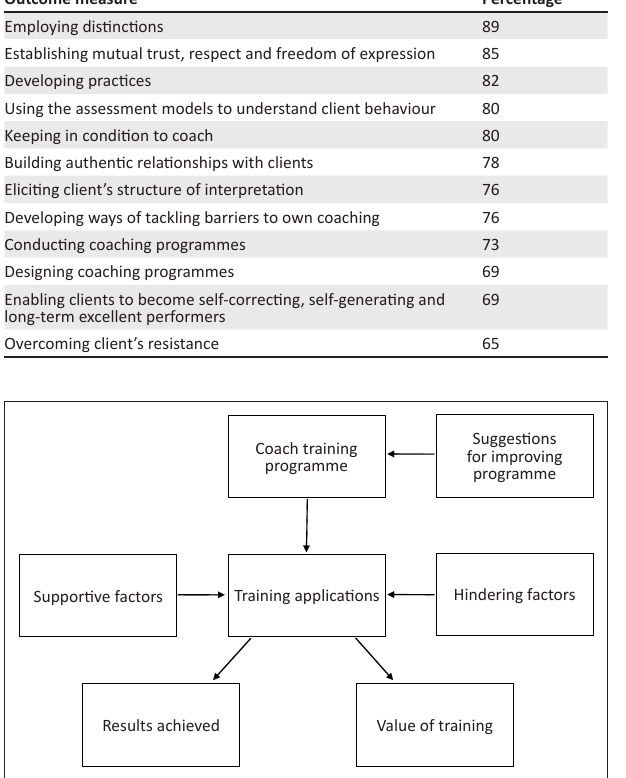
FIGURE 2: Themes from qualitative data